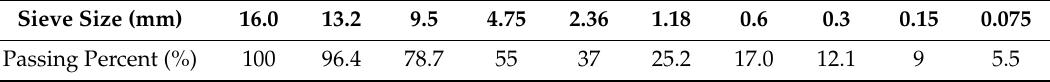
Table 7. The aggregate gradation used in this